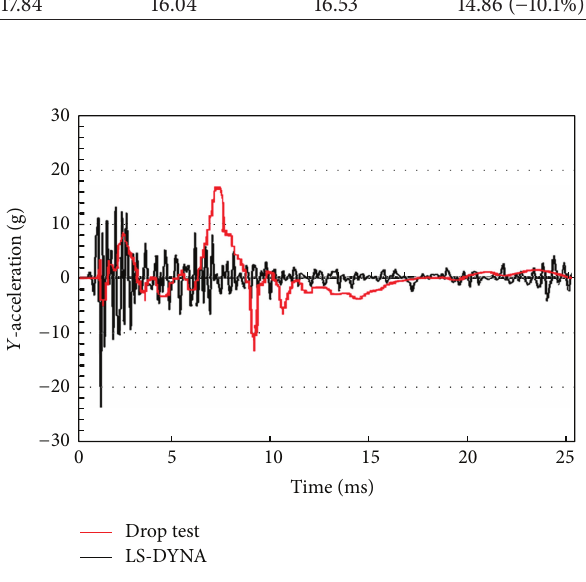
Figure 9: Vertical acceleration of point A with resilient material EVA 55. Figure 10: Vertical acceleration of point A with resilient material